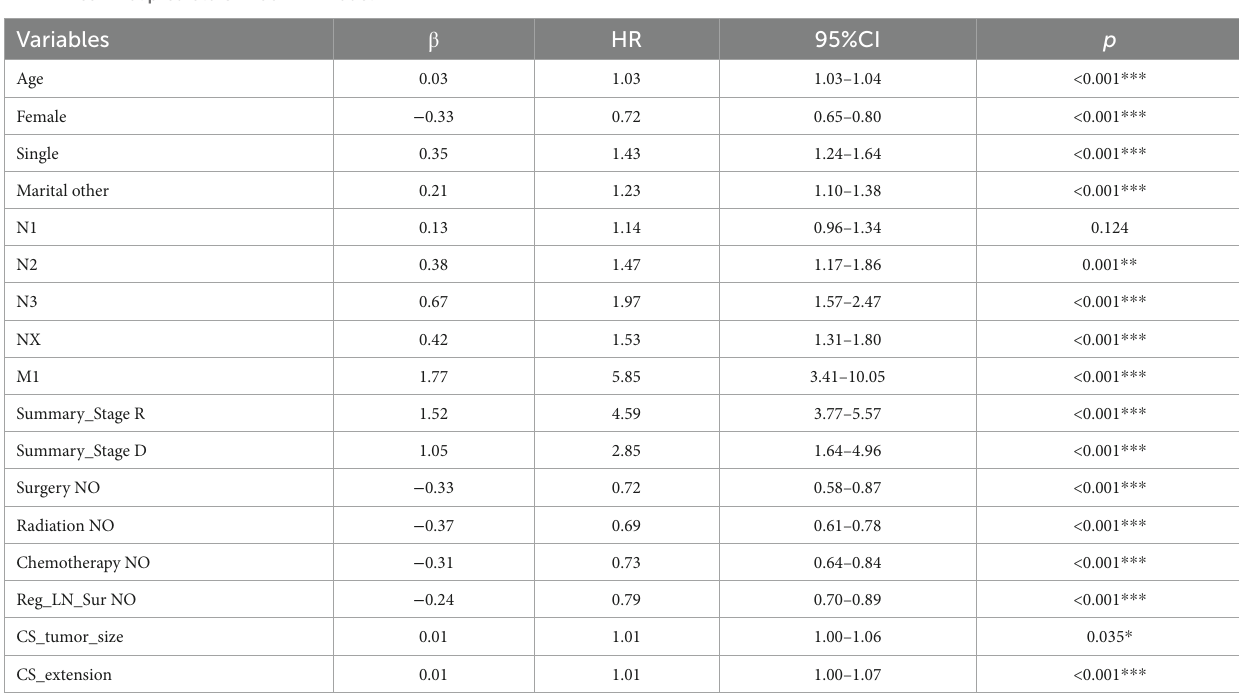
TABLE 2 Survival predictors in Cox PH